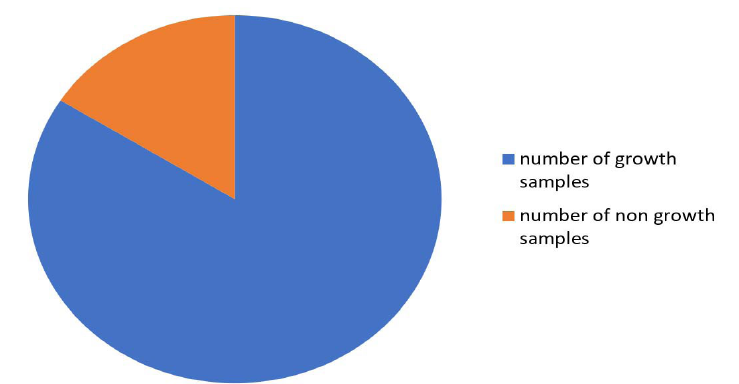
Fig. 3. Study population for growth and non-growth.